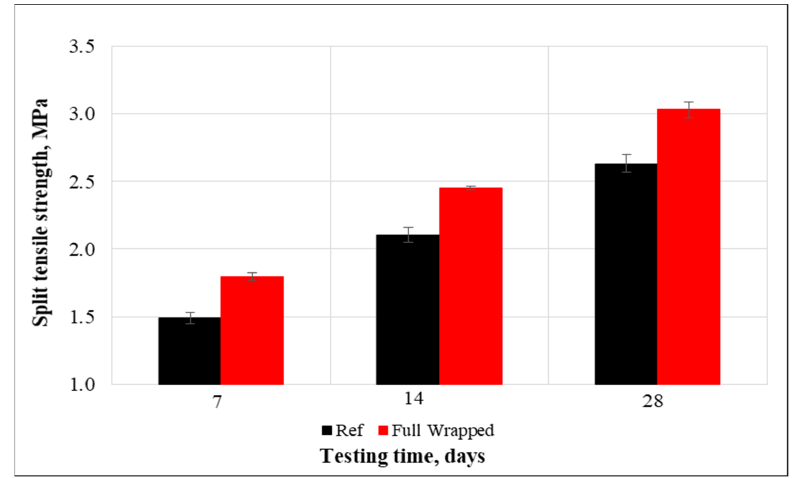
Figure 9. Tensile split strength of concrete .